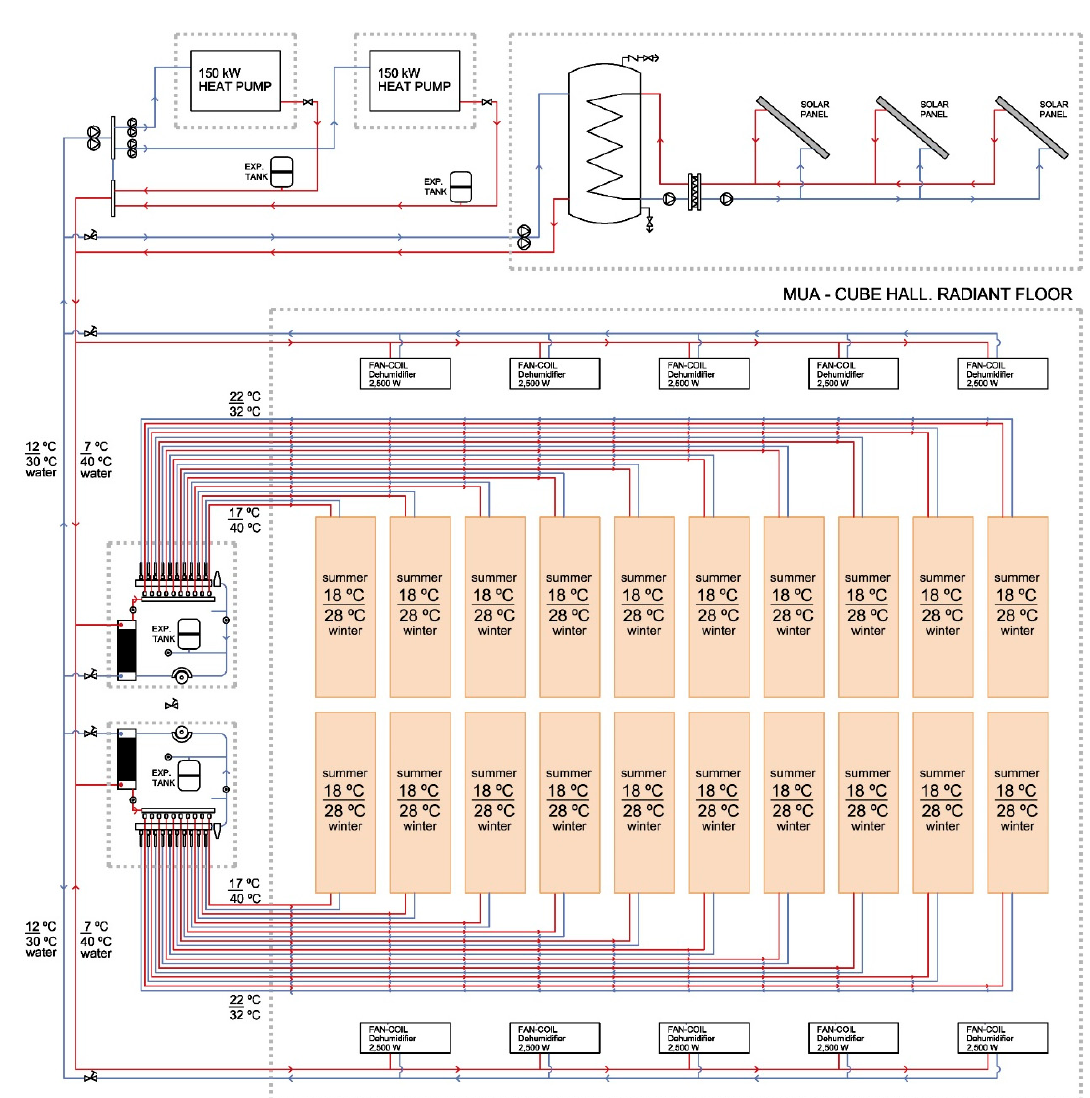
Figure 9. Schematic diagram of the installation of capillary mats and fan-coil dehumidification modelled in Design Builder.